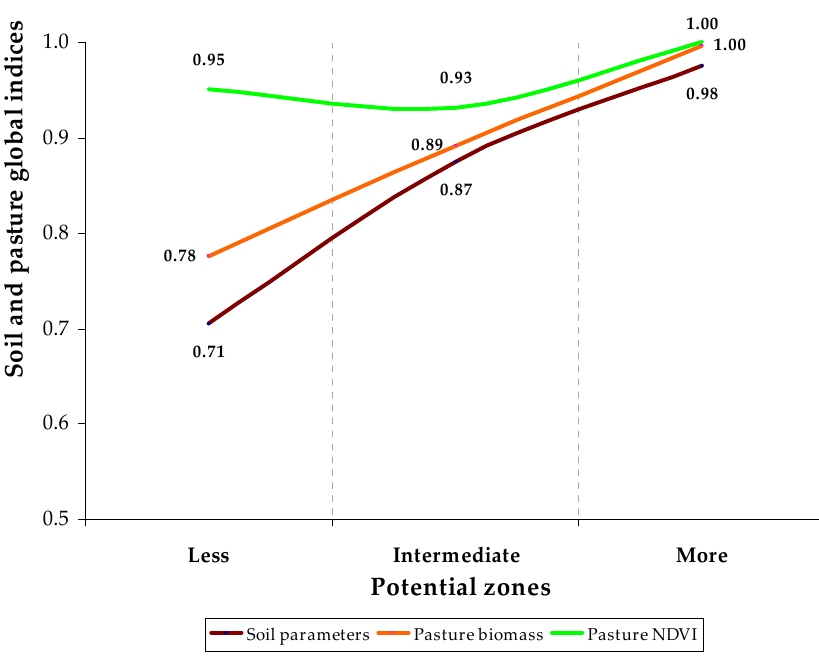
Figure 13. Global index of soil and pasture parameters for each homogeneous management zone in the set of six experimental fields.